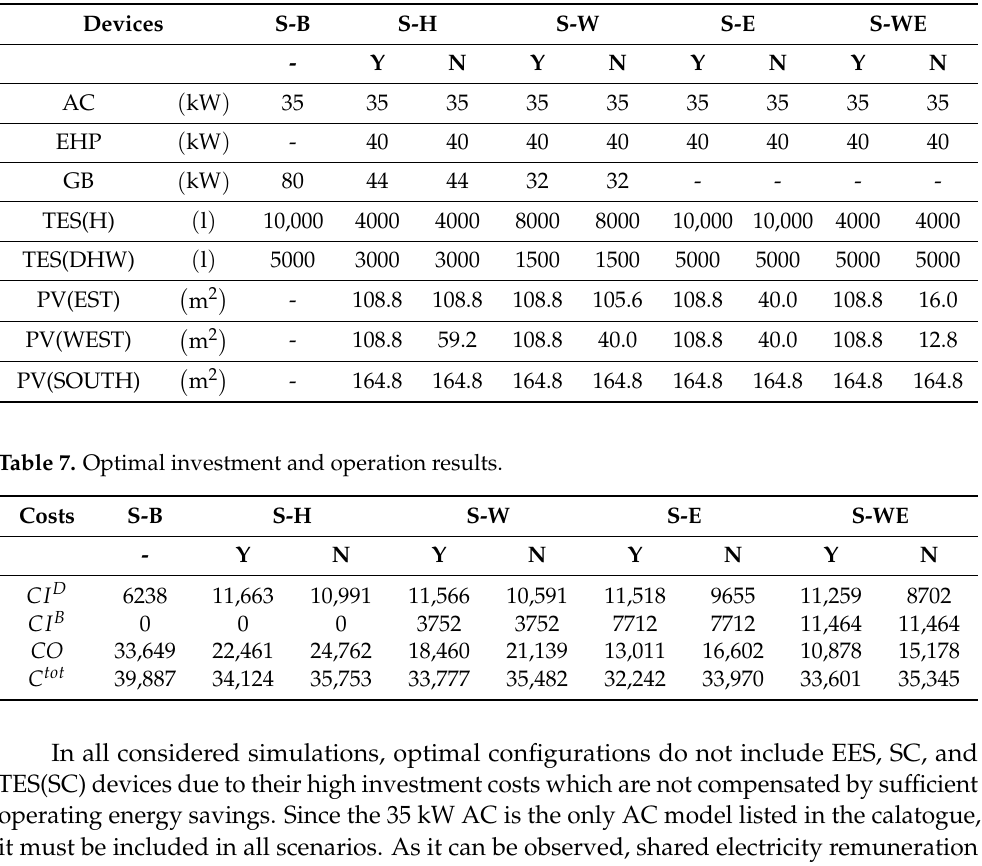
Table 6. Typology and size of devices included in considered scenarios.